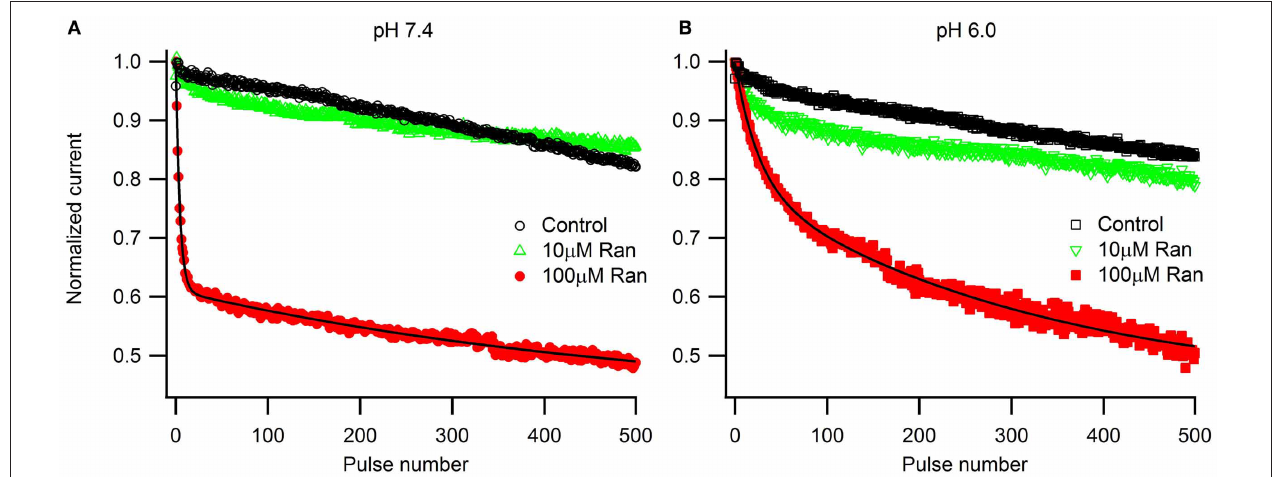
FIGURE 5 | Use-dependent inactivation by trains of five hundred 300ms pulses to − 10mV applied at 1Hz from holding potential − 130mV at extracellular pH 7.4 (A) and 6.0 (B). Error bars removed